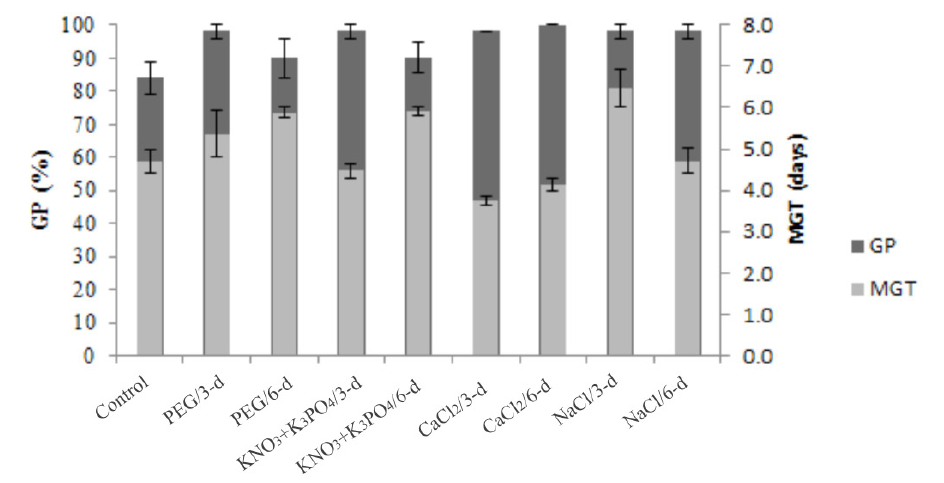
Figure 1: Variation in GP and MGT at 25°C for different priming treatments. Vertical bars represent ±